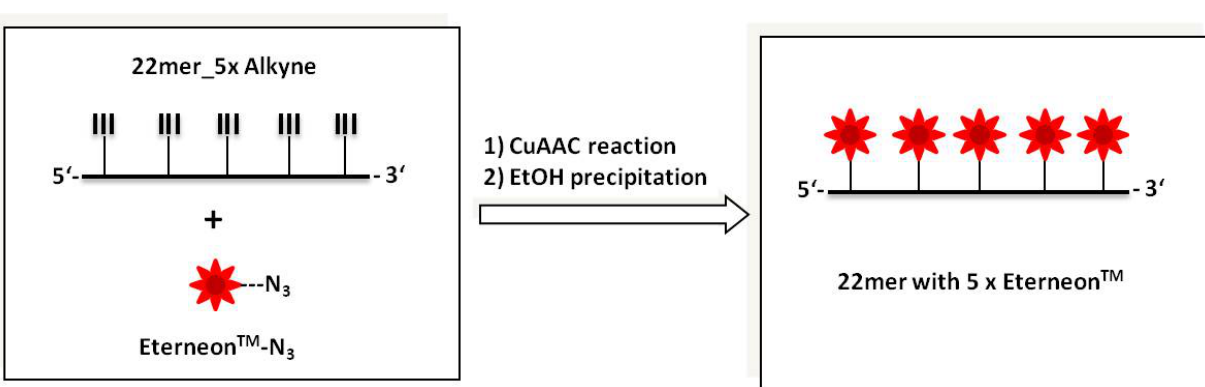
Figure 4. Graphic representation of high density functionalization via click chemistry